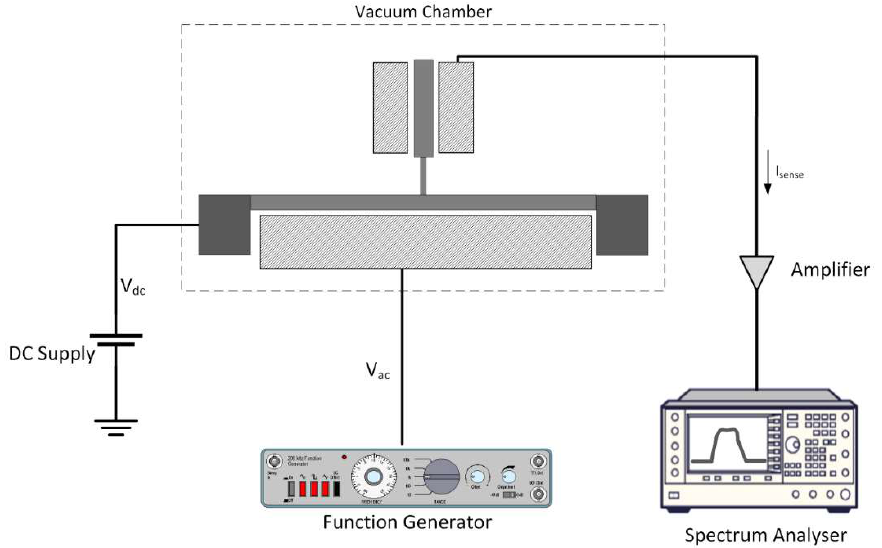
Figure 10. Experimental setup for frequency sweep. Both excitation and sensing are done by electrostatic transduction.